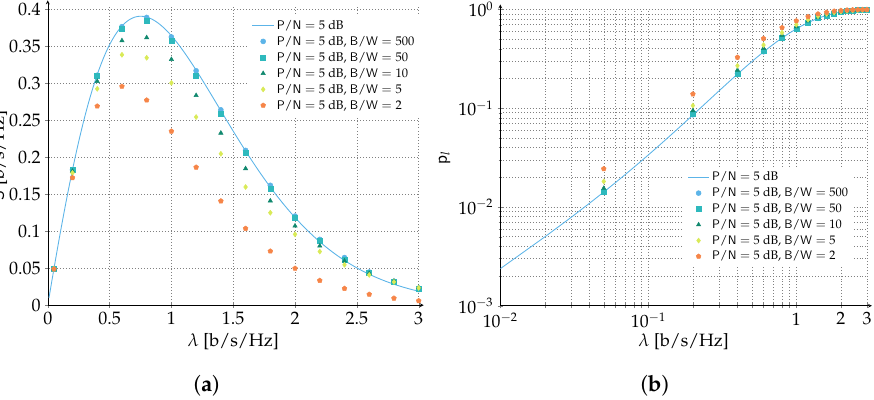
0, 5, 20 dB. ( a ) Spectral ∈ { }